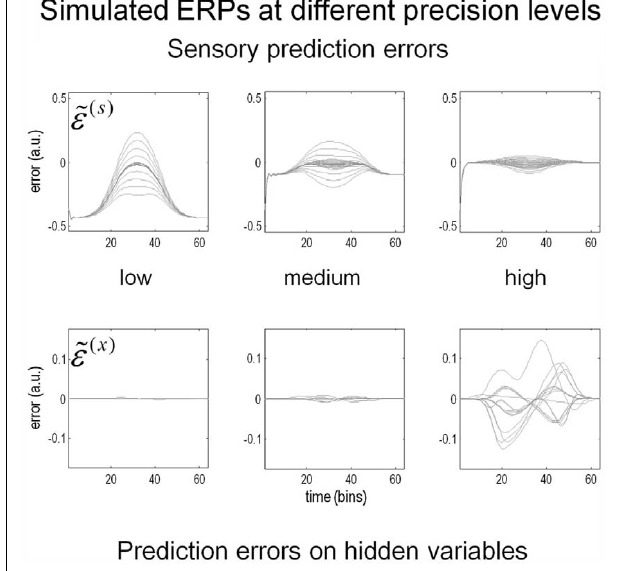
FIGURE 9 | Contrast and prediction error. As stimulus contrast increases, prediction error is redistributed from sensory input to hidden variables. At high levels of precision, sensory information induces prediction errors at higher levels, which in turn explain away prediction error at the sensory level.The higher level prediction errors at high precision reflect increasing confidence that the reflectance is different from the prior expectation of zero. Please see main text for further